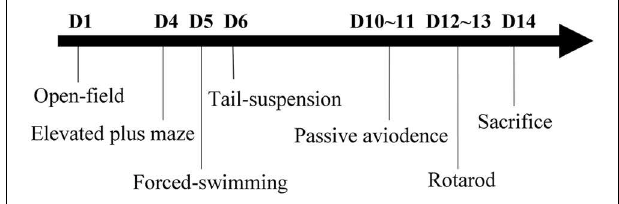
FIGURE 1 | Experimental paradigm of the behavioral